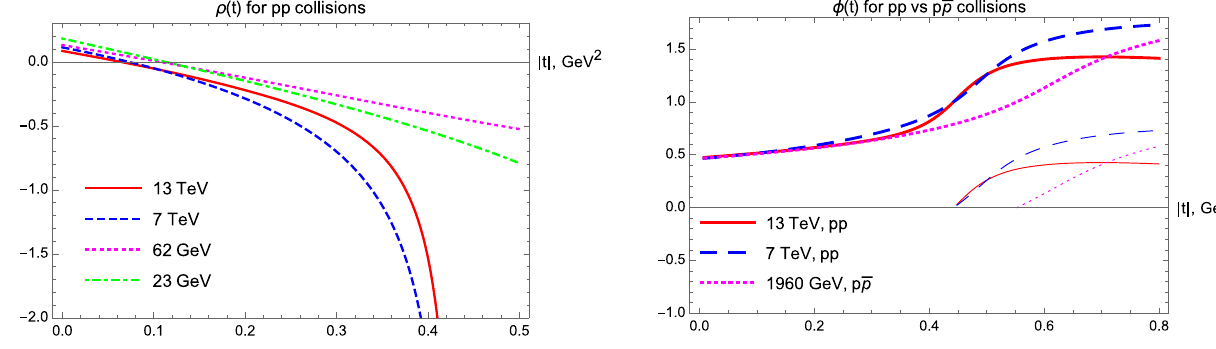
Fig. 15 ρ( t ) -parameter for pp elastic scattering collisions